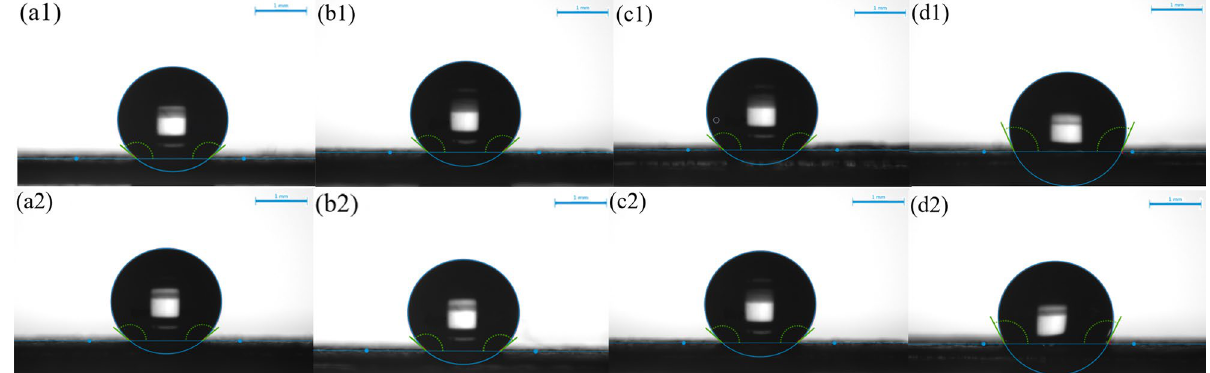
Figure 7. The contact angles of the air-brushed electrodes with different ionomer contents, (1) Nafion and (2) PTFE respectively. (a) 3:1, (b) 5:1, (c) 7:1, (d)